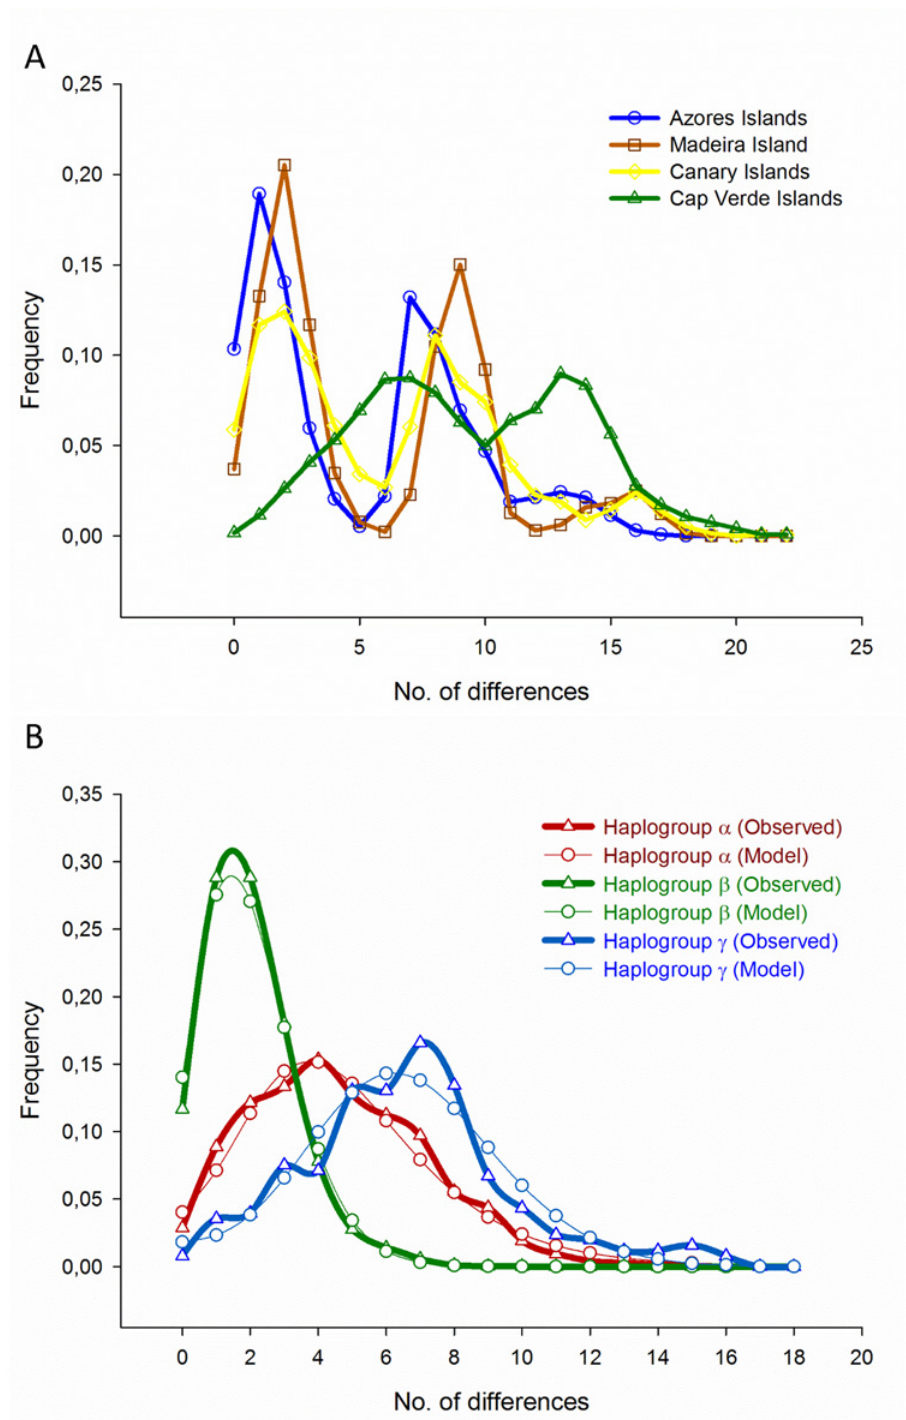
Fig 6. Mismatch distributions for Megabalanus azoricus . Mismatch distributions estimated for (A) each of the sample sites in the four Macaronesian archipelagos (Azores, Madeira, Canary, and Cabo Verde Islands) and (B) for the three identified haplogroups distributed along the Macaronesian sampling